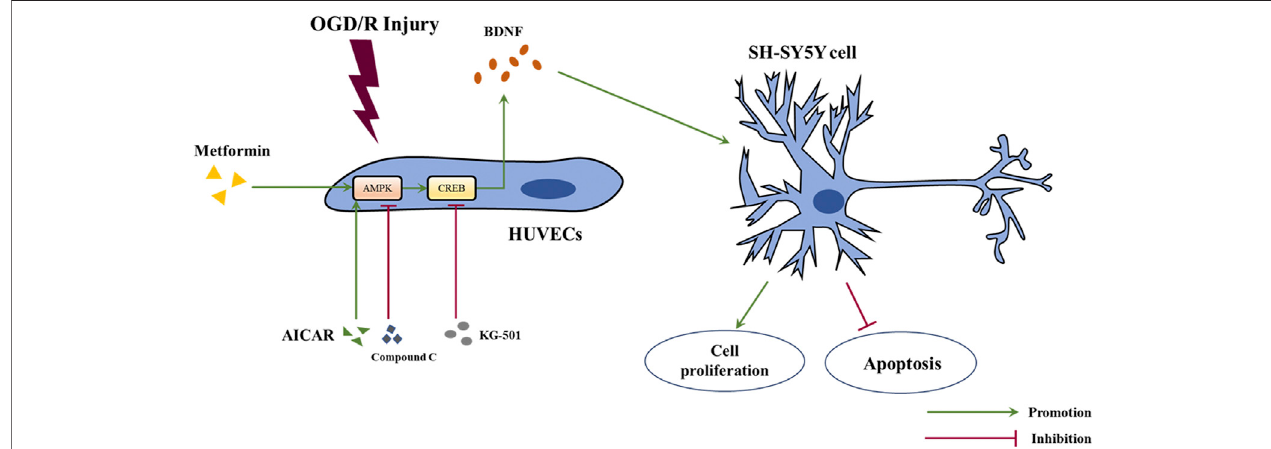
FIGURE9| Schematicdiagramofthemechanismofmetformininthisstudy.Abbreviations:OGD/R,oxygen-glucosedeprivation/reoxygenation;HUVECs,human umbilical vein endothelial cells; BDNF, brain-derived neurotrophic factor.